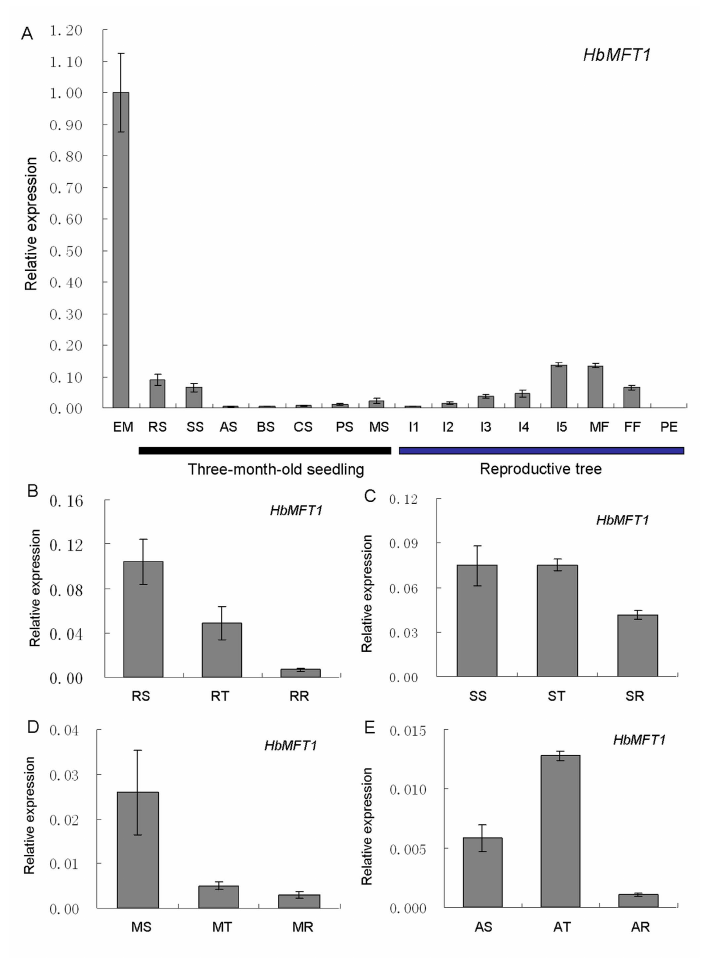
Figure 3. Expression analysis of HbMFT1 in rubber tree. ( A ) Tissue-specific expression analysis of HbMFT1 . EM, RS, SS, AS, BS, CS, PS, MS, embryos and roots, stems, shoot apices, bronze, color change, pale-green and mature leaves of three-month old seedlings; PE, MF, FF, pericarps, open male and female flowers; I1, I2, I3, I4 and I5, five different developmental-stage inflorescences; ( B – E ) expression of HbMFT1 in roots, stems, mature leaves and shoot apices of rubber trees at different ages (three months, two years and ten years). RS, SS, MS and AS, roots, stems, mature leaves and shoot apices of the three-month-old seedlings; RT, ST, MT and AT, roots, stems, mature leaves and shoot apices of the two-year-old trees; RR, SR, MR and AR, roots, stems, mature leaves and shoot apices of the ten-year-old trees (adult trees). HbRH2b , HbRH8 and HbYLS8 were used as reference genes for qRT-PCR analysis. Values were means ˘ SE from three independent biological